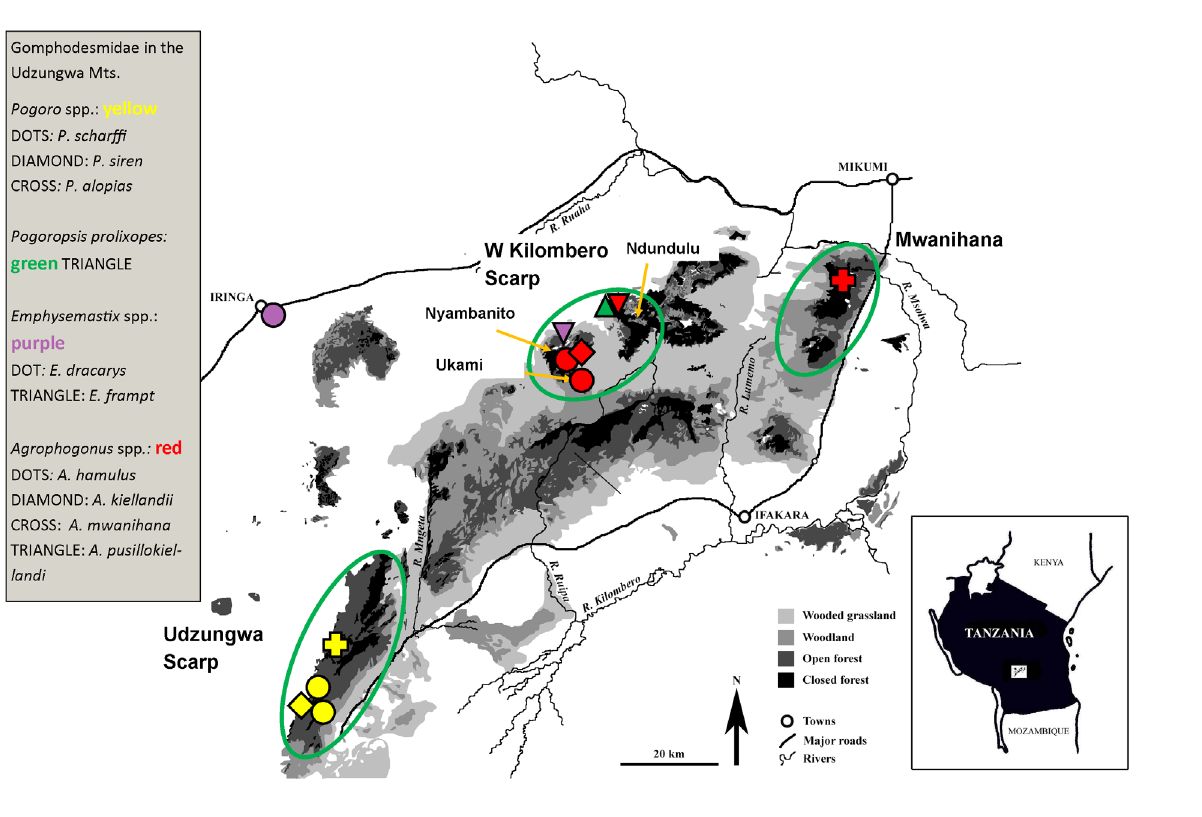
Fig. 2. Map of the Udzungwa Mts showing collection sites for gomphodesmids. Based on Marshall et al. (2010: fig.